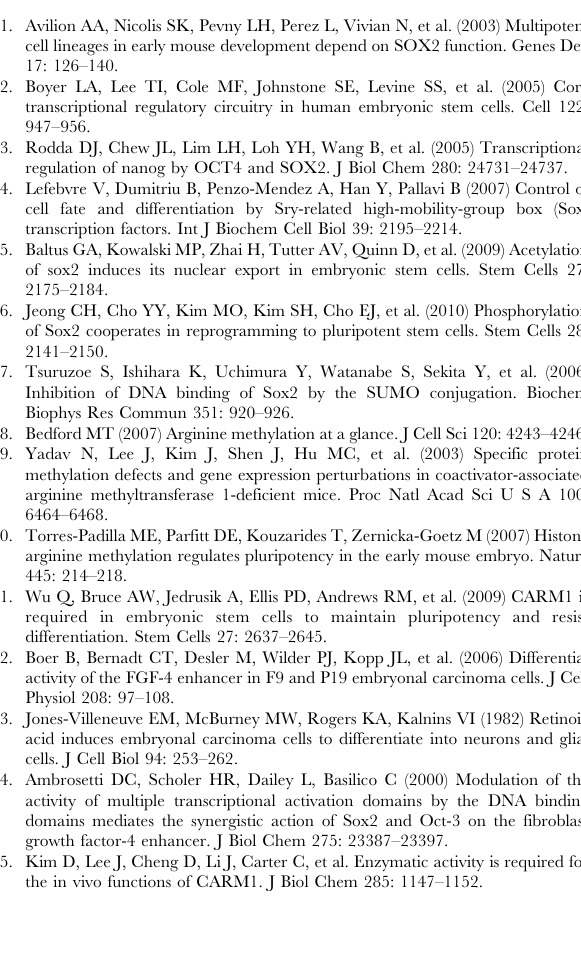
Figure S6 Schematic representation of Sox2 nuclear localization signals. The key residues of NLSs are underlined, and an asterisk indicates the identified methylation site Arg113. The residues that are mutated in Sox2-mNLS1 are also shown. Figure S7 CARM1-mediated methylation may be a regulation mechanism shared by certain other Sox family members. Arg113 was shown. NLS2 was underlined, Arg113 and